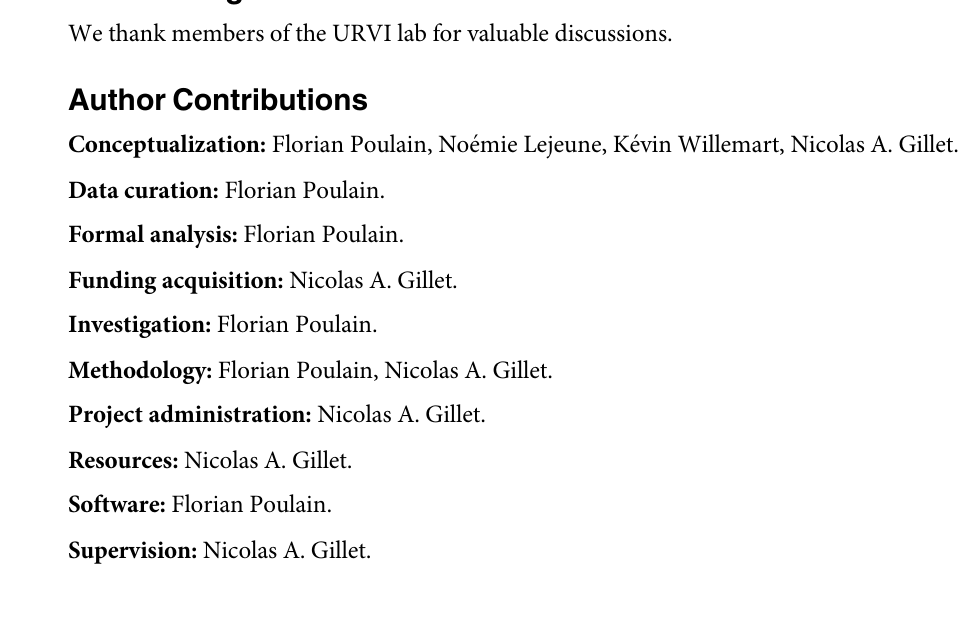
classification. Each point represents a unique viral genome. C. The observed/expected ratios of WCW trinucleotide at various codon positions and on both strands (i.e. NWCWNN, WCW, NNWCWN, NWGWNN, WGW and NNWGWN) were calculated for the NWCWNN and/or NWGWNN depleted viral species and depicted by a heatmap. A colored scale with increasing shades of blue indicating depletion and increasing shades of red indicating enrichment. P-val- ues were calculated by Student’s unpaired, two-tailed t-test (NS for not significant, � p < 0.05, �� p < 0.01, ��� p < 0.001). D. List of the putative APOBEC1-footprinted viral genes (displaying NWCWNN or NWGWNN depletion) and belonging to an otherwise non-depleted viral genome. S12 Fig. A3 footprint in human oncogenic viruses. NTC and NNGANN observed/expected ratios were calculated for each available coding sequence of eleven well-known cancer-related viruses. Each point represents a unique viral coding sequence. The coding sequences are grouped and colored according to gene name. S1 Table. Genomic K-mer ratios for human viruses. Observed/expected K-mer ratios for each genomic human viral sequence (available for download at https://doi.org/10.5061/dryad. n8pk0p2sd). S2 Table. Genic K-mer ratios for human viruses. Observed/expected K-mer ratios for each genic human viral sequence (available for download at https://doi.org/10.5061/dryad. n8pk0p2sd). S3 Table. Genomic K-mer ratios for non-human viruses. Observed/expected K-mer ratios for each genomic and genic non-human viral sequence (available for download at https://doi.